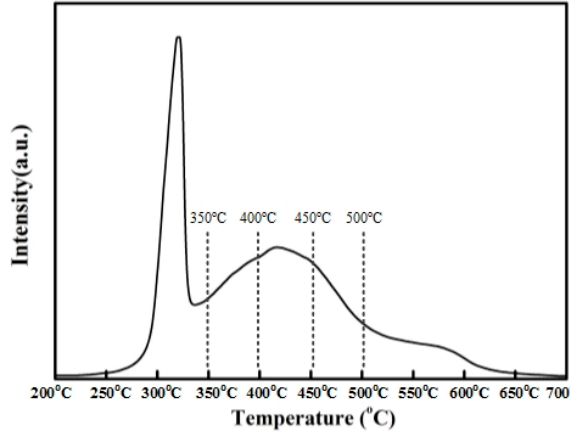
Figure 7. H 2 -TPR of catalyst precursors.